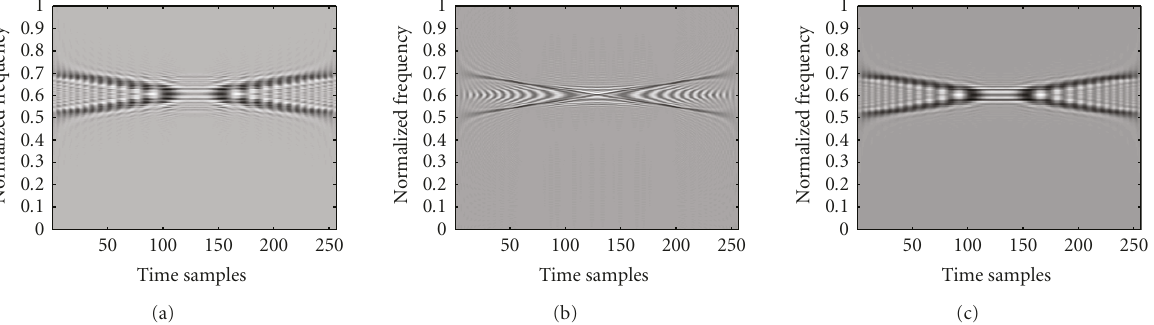
Figure 3: Time-frequency distribution for two crossing chirp signals. (a) Scale covariant distribution, (b) Wigner distribution, and (c) Reduced interference distribution using the Born-Jordan kernel.